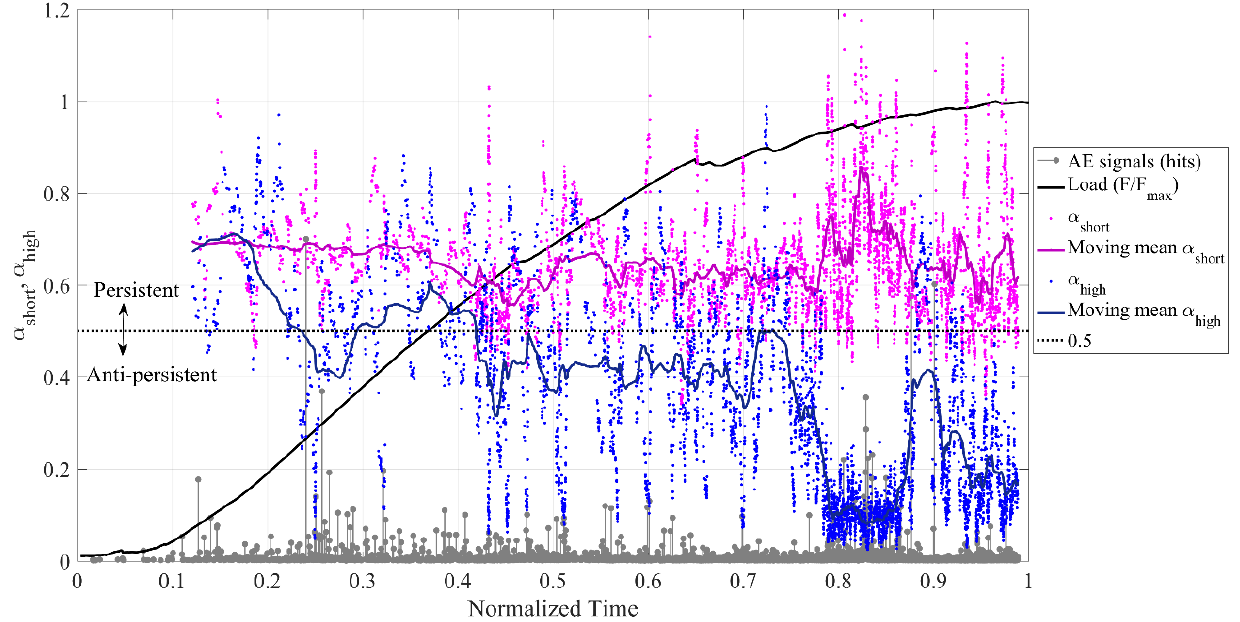
Figure 9. DFA considering short-term ( α short ) and long-term ( α high ) windows for the GFRP plate. The load and AE signals out of scale.